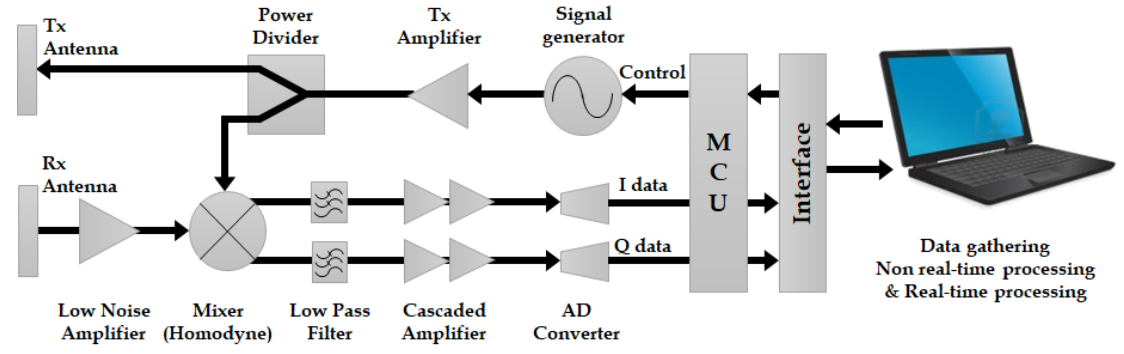
Figure 3. Block diagram of the low-cost & short-range 24 GHz Doppler Radar.